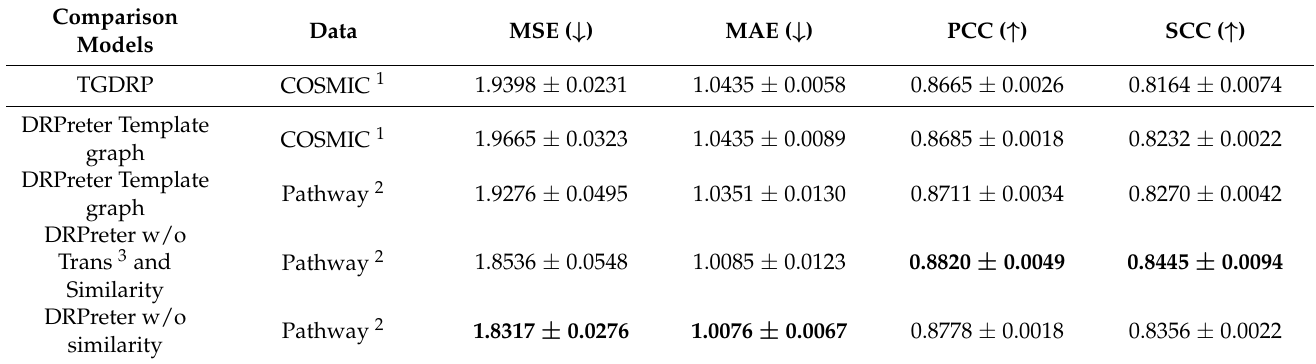
Table 3. Internal validation using 10-fold cross-validation on 5 random